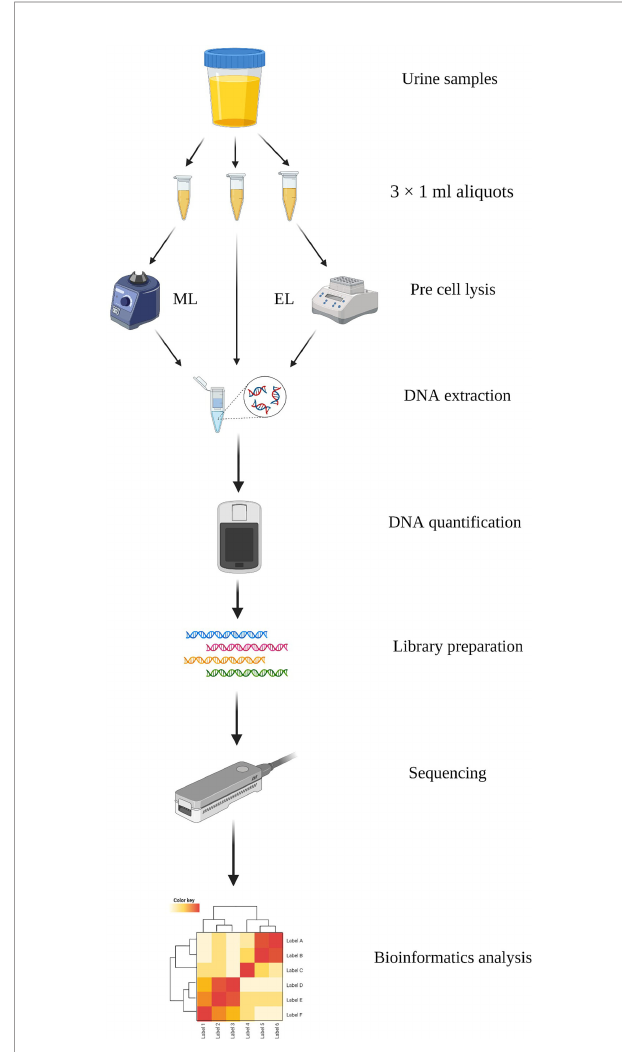
FIGURE 1 | Schematic work fl ow of the study. DNA was extracted with three methods from urine samples and performed sequencing based on MinION. Created with